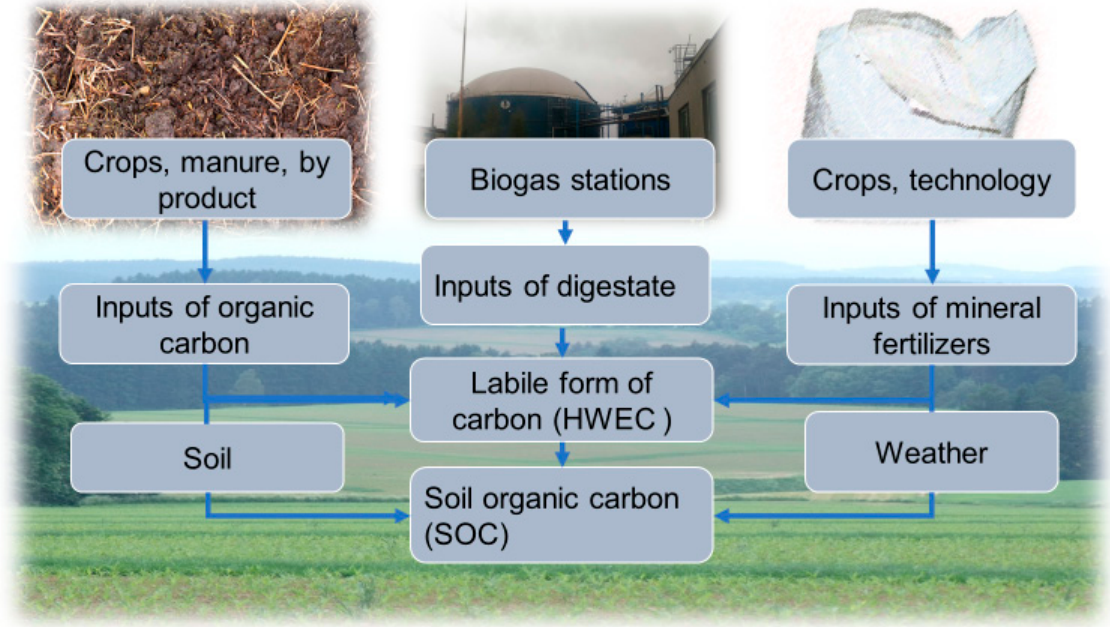
Figure 1. General scheme of SOC and HWEC formation. The analysed fields are located in the climatic regions 2 (10 localities), 3 (26 localities), 5 (20 localities), 6 (1 locality) and 7 (11 localities) (Table 1). The soil types represented are: Chernozems, Luvisols, Cambisols, Fluvisols and Planosols (51). The specific